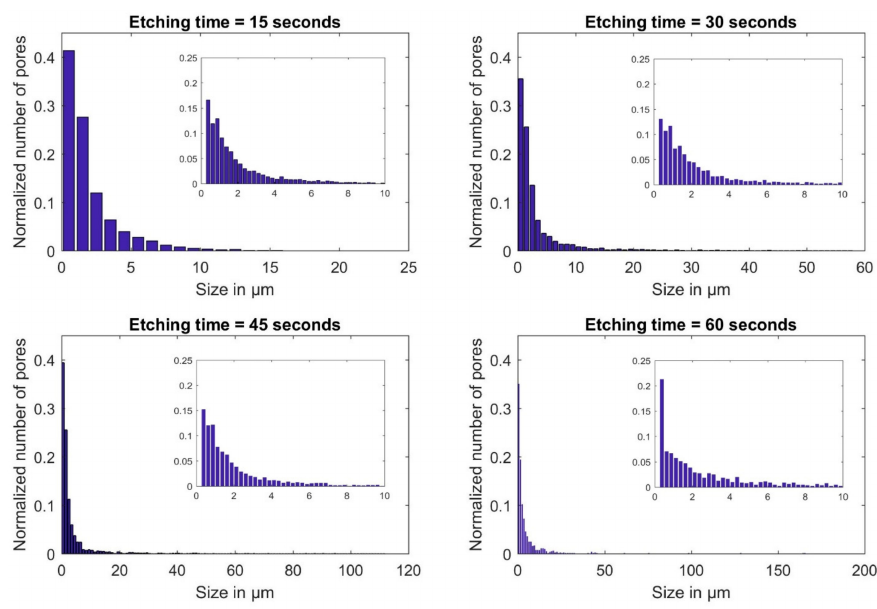
Figure 8. Distribution of pores in the gold film at di ff erent etching rates, where the thickness of the gold film for all wafers is ~800 nm and the concentration of the GO dispersion is 4 mg / mL.